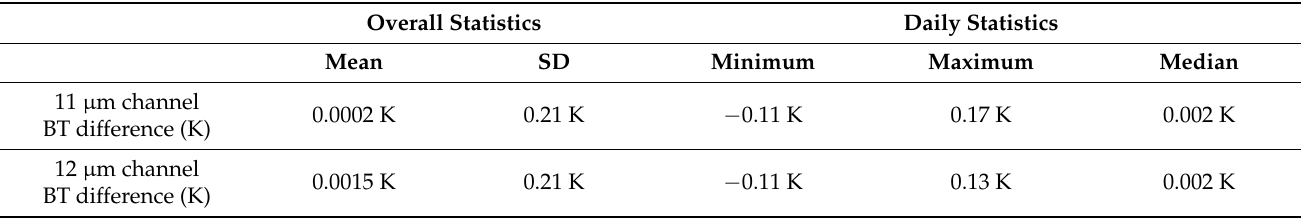
Table 2. The statistics of the HY-1C COCTS-corrected BTs minus IASI BT differences for the 11 and 12 µ m